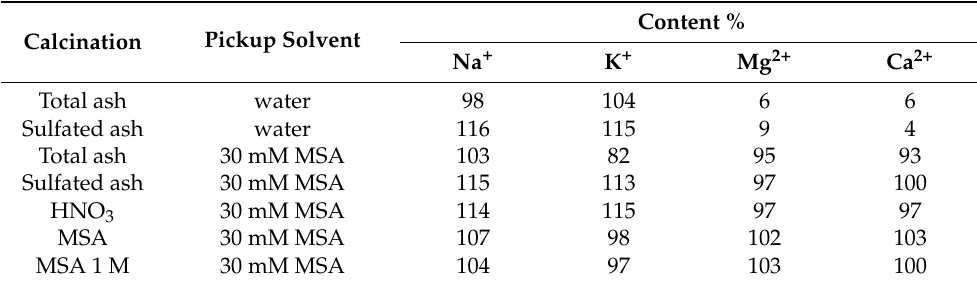
Table 1. Influence of different calcination conditions and pickup solvents on the determination of sodium, potassium, magnesium and calcium.